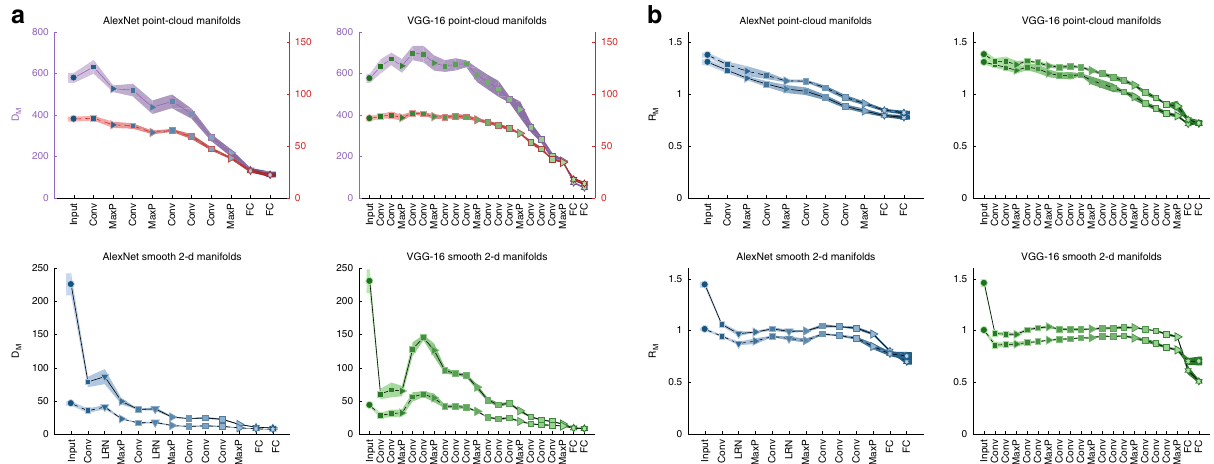
Fig. 6 Manifold geometry. a Mean manifold dimension for point-cloud manifolds of AlexNet and VGG-16 (top, full line: full-class manifolds, dashed line: top 10% manifolds) and smooth 2-d manifolds for the same deep networks (bottom, full line: translation manifolds, dashed line: shear manifolds). AlexNet top 10% manifolds results already appeared as “ after training ” results from Fig. 3f. Values of point-cloud top 10% manifolds are showed against a secondary y-axis (color-coded by the markers edge) to improve visibility. b Mean manifold radius for point-cloud manifolds of AlexNet and VGG-16 (top, full line: full-class manifolds, dashed line: top 10% manifolds) and smooth 2-d manifolds for the same deep networks (bottom, full line: translation manifolds, dashed line: shear manifolds). AlexNet top 10% manifolds results already appeared as “ after training ” results from Fig. 3g. Line and markers indicate mean value over different choices of objects; surrounding shaded areas indicate 95% con fi dence interval. The x -axis labels provides abbreviation of the layer types. Marker shape represents layer type (circle — pixel layer, square — convolution layer, right-triangle — max-pooling layer, hexagon — fully connected layer, down-triangle — local normalization layer). Features in linear layers are extracted after a ReLU nonlinearity. Color (blue — AlexNet, green — VGG-16) changes from dark to light along the